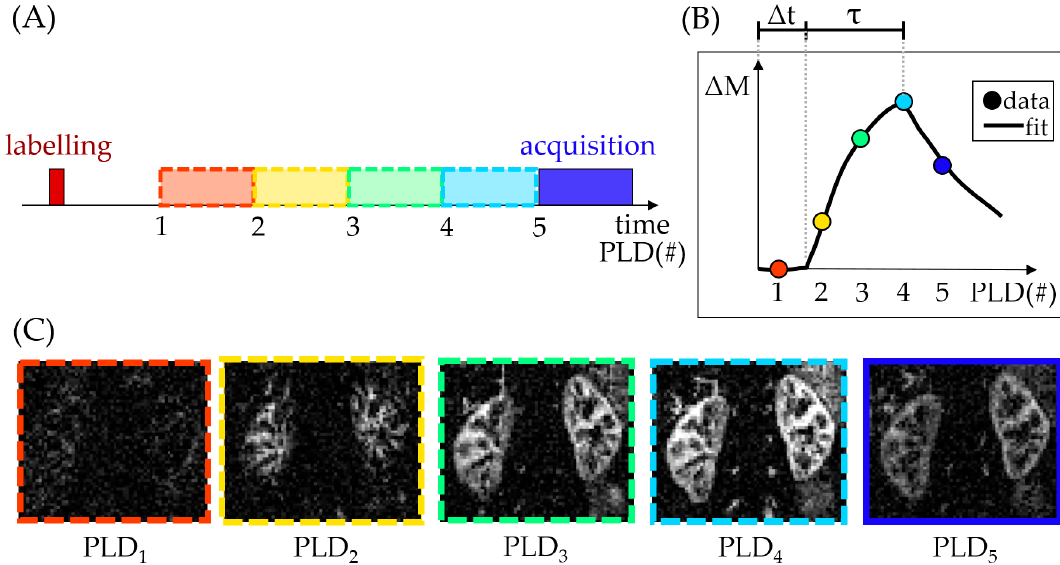
Figure 2. Multiple post-labeling delay (multi-PLD) ASL experiment (data acquired at a field strength of 1.5T). The schematic shows arbitrary PLDs. The actual PLDs used to acquire the ASL data in this figure were (in seconds): 0.1, 0.5, 0.9, 1.3, 2.7. ( A ) Simplified diagram of a multi-PLD acquisition. Note that after labeling, only one PLD image/volume is acquired at a time (in this case, 5 acquisitions would be necessary, each at different PLD); ( B ) Difference signal ( Δ M) at each PLD and corresponding fit, highlighting parameters beyond renal blood flow ( Δ t and τ ); ( C ) Difference image at each PLD.